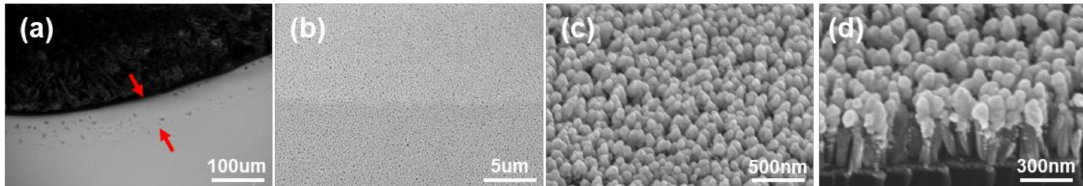
Figure 3. FE-SEM images of urine dropped on a SERS substrate: ( a ) 250 times magnification, containing a dried droplet, diffused area, and bare SERS area; ( b ) 5k and ( c ) 50k magnification showing the interface between the diffused and bare area; ( d ) cross-sectional image showing Au-coated ZnO